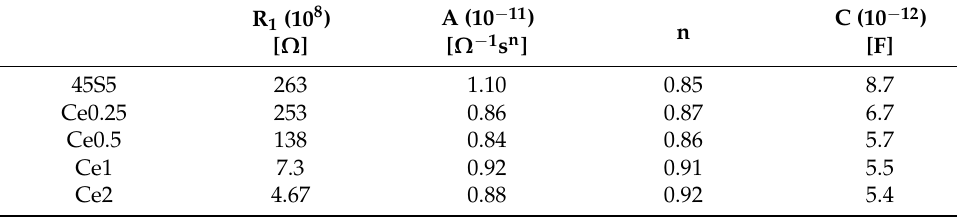
Table 3. Electrical equivalent circuit fitting